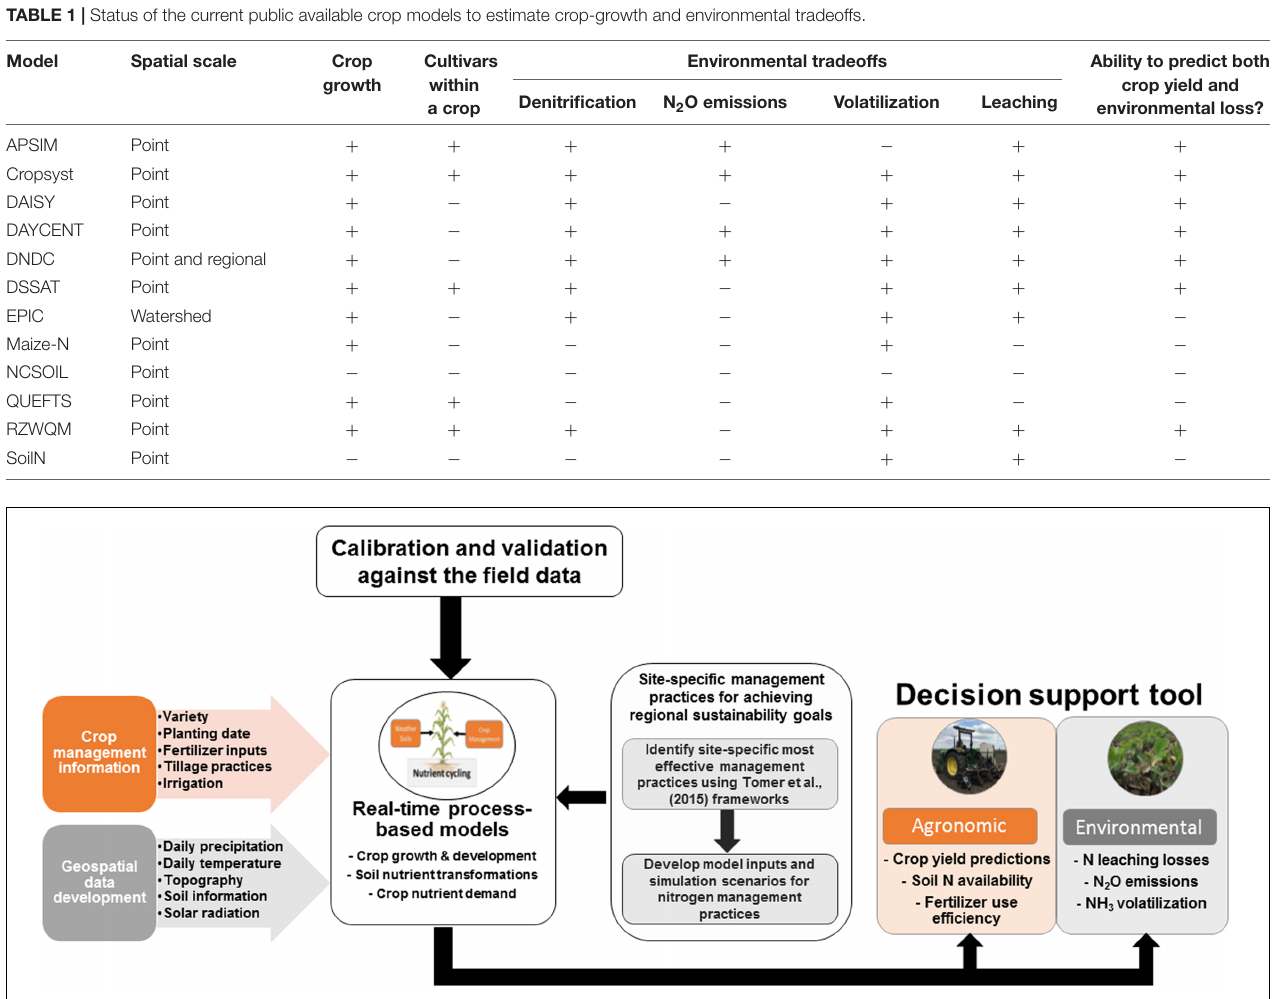
FIGURE 1 | Geospatial framework vision for incorporating environmental effects into N management decision support tools. In the first step, publicly available crop models are integrated with grower-entered management information and gridded soil and climate data to estimate crop growth and soil nutrient transformation processes and quantify sustainability and crop production tradeoffs. To identify site-specific nitrogen management practices for achieving regional sustainability goals, additional attributes to consider in geospatial model development are (1) the need to identify the most effective nitrogen management practices for reducing N losses, for example using watershed-scale frameworks developed by Tomer et al. (2013), and (2) the need for model outputs to be transformed into user-friendly recommendations related to current environmental quality goals such as N leaching and soil N 2 O emissions per unit area and